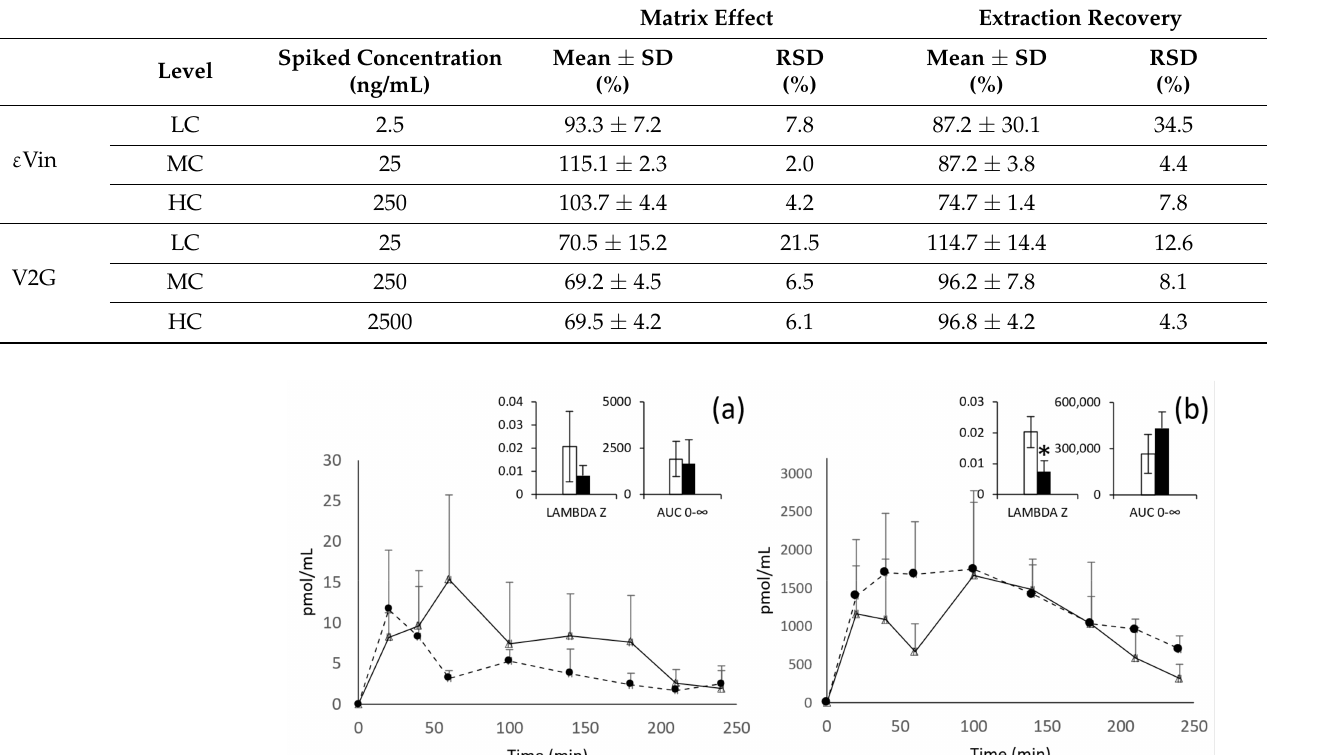
Table 2. Matrix effect and extraction recovery of ε Vin and V2G in rat plasma.